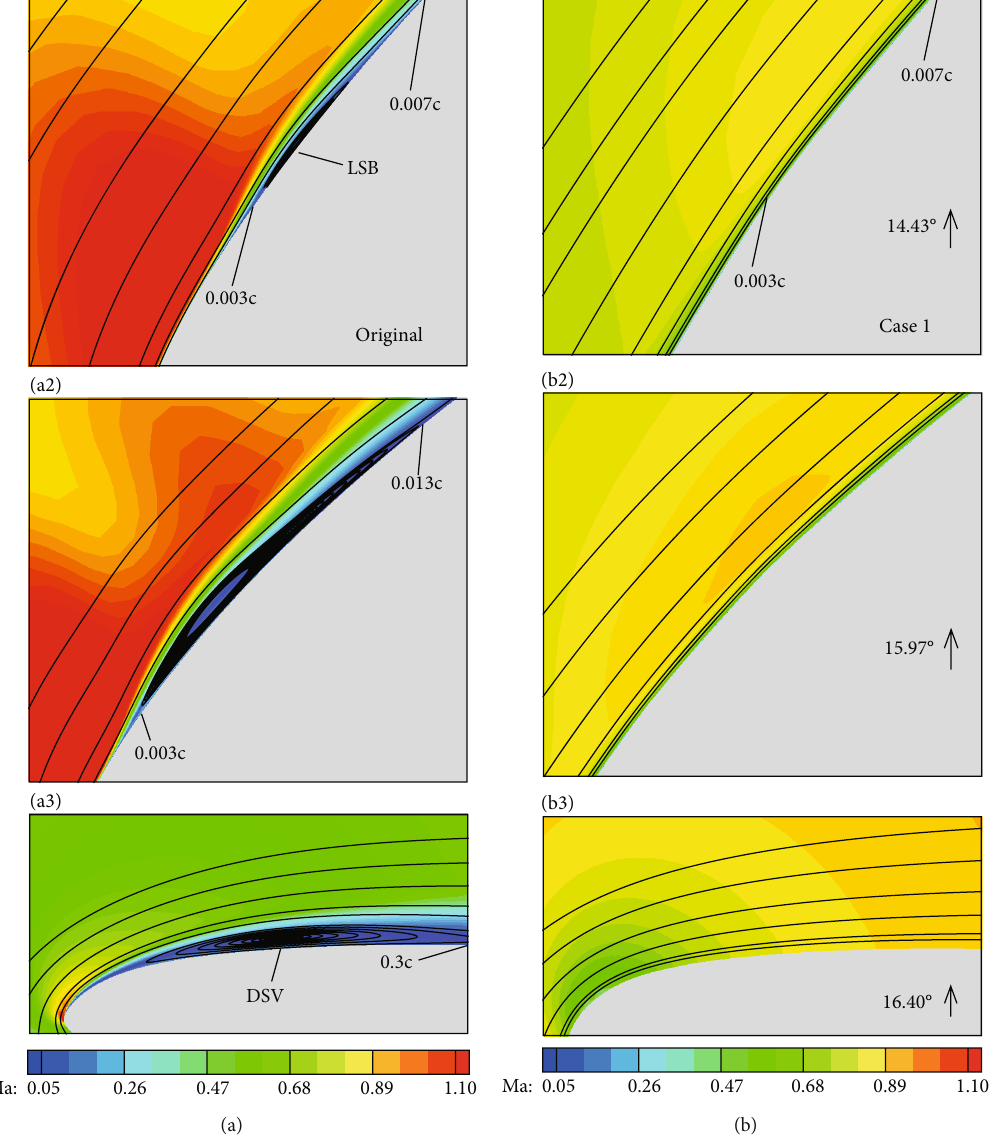
Figure 16: Streamlines and Mach number contours near the leading edge in airfoil frame of reference at di ff erent angles of